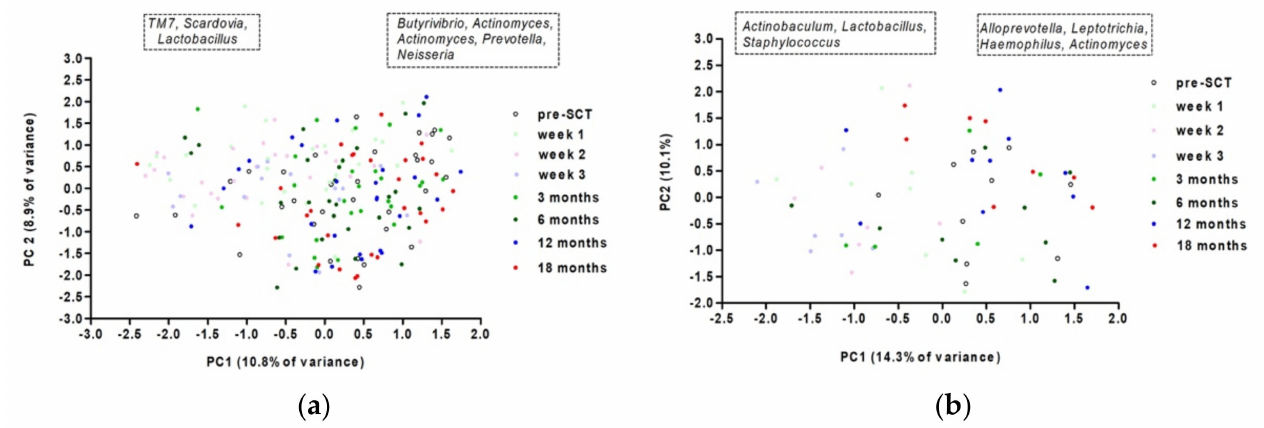
Figure 4. PCA on oral microbiome over time for patients who did not ( a ) and did ( b ) experience oral mucositis; left box more abundant taxa at low values of PC1 loadings; right box more abundant taxa at high values of